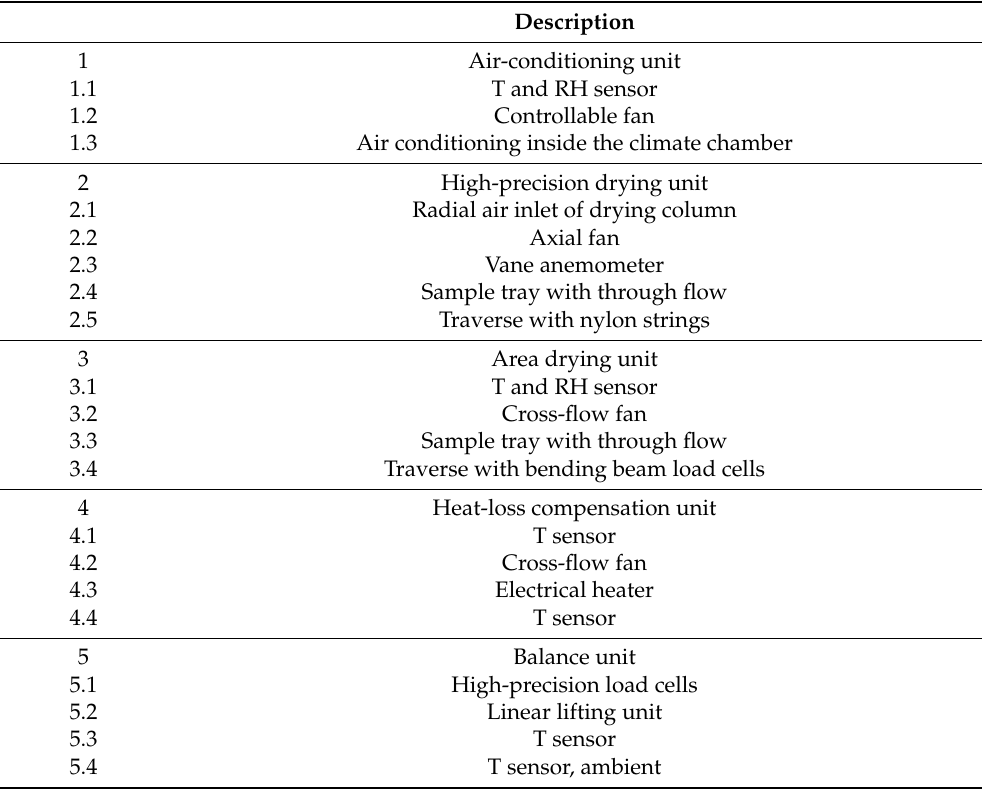
Table 1. Legend for the high-precision laboratory dryer HPD TP3+ in Figures 1 and 2.